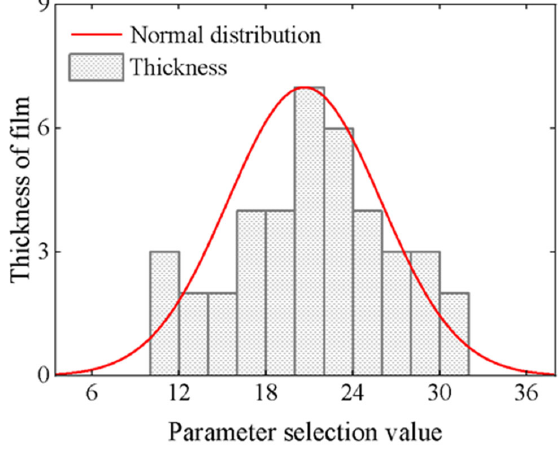
Figure 10. Distribution histogram of the thickness randomly determined in the range of interest.